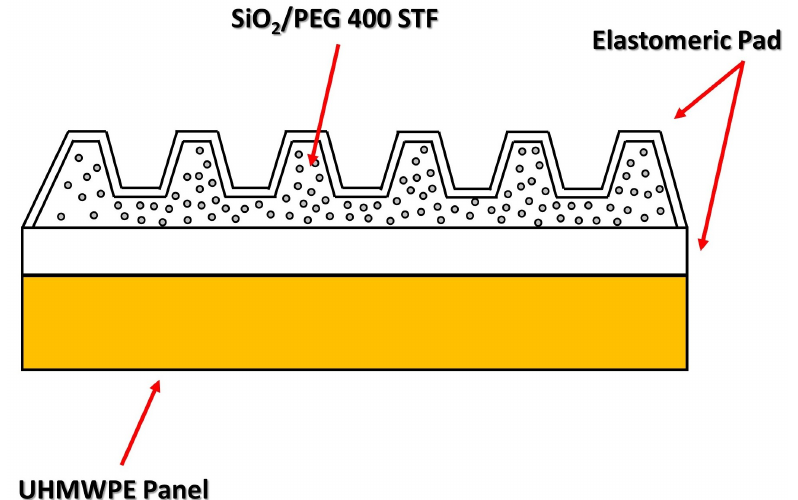
Figure 9. Schematic of the ballistic plate composed of Dyneema panels + elastomeric anti-trauma pads with shear thickening fluid. Adapted with permission from Ref. [168]. Copyright 2017,